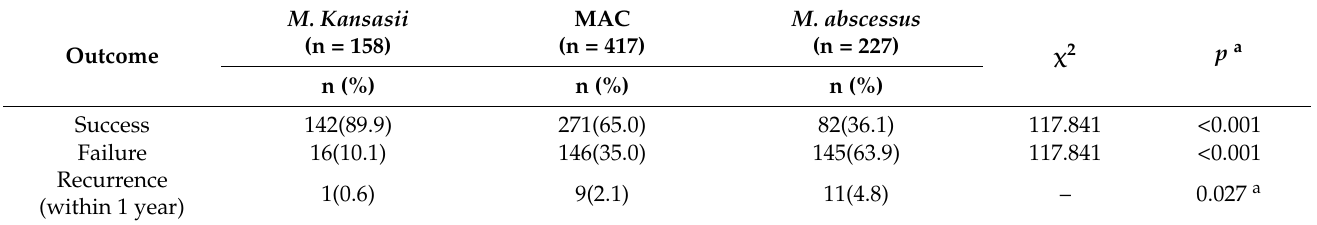
Table 2. Outcomes of NTMPD patients infected with the three major